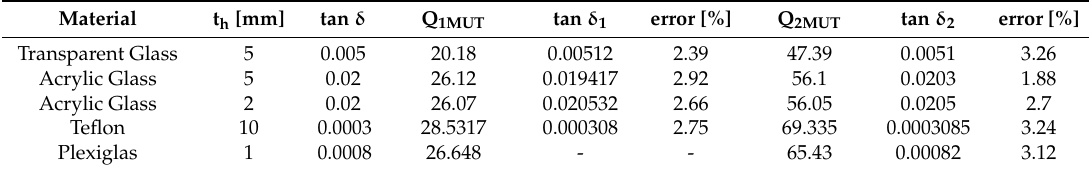
Table 3. Loss tangent for di ff erent materials under test.